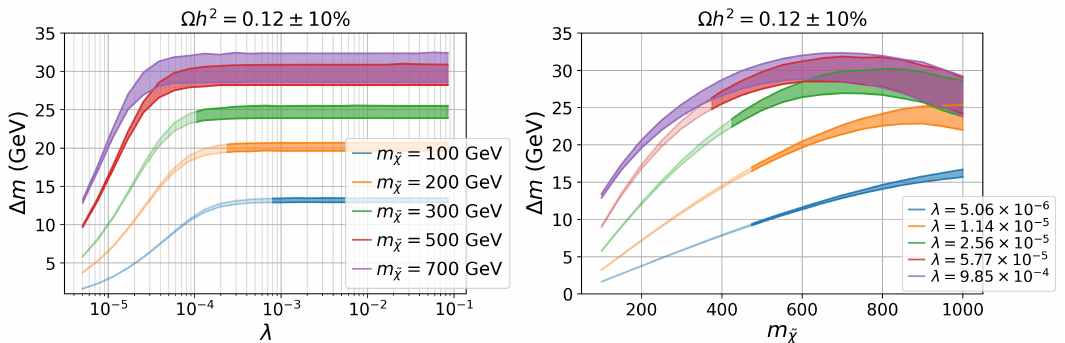
Figure 11: Bands of Ω h 2 = 0.12 ± 10% in the plane of ∆ m vs λ for several DM masses (left) and in the plane of ∆ m vs m for several values of λ (right); the light-shaded ˜ χ areas are excluded by SM ODEL S